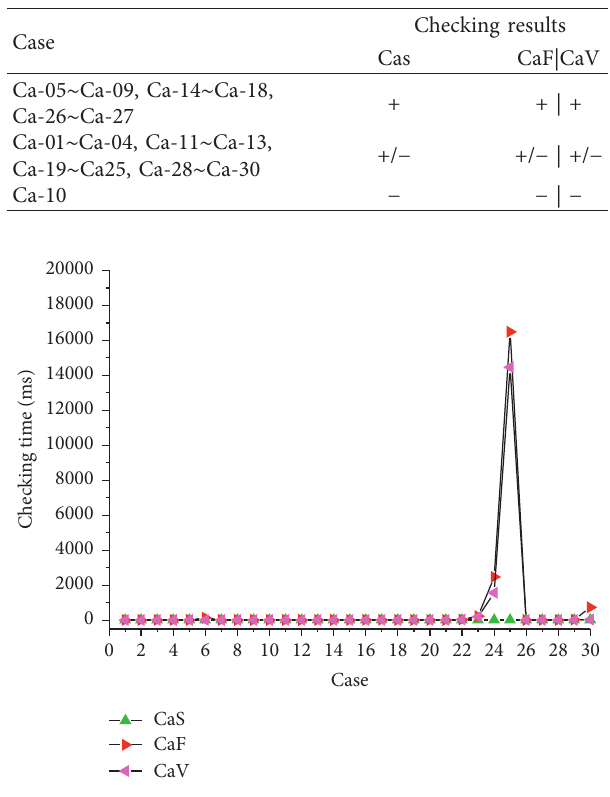
Table 2: Results of correctness checking.